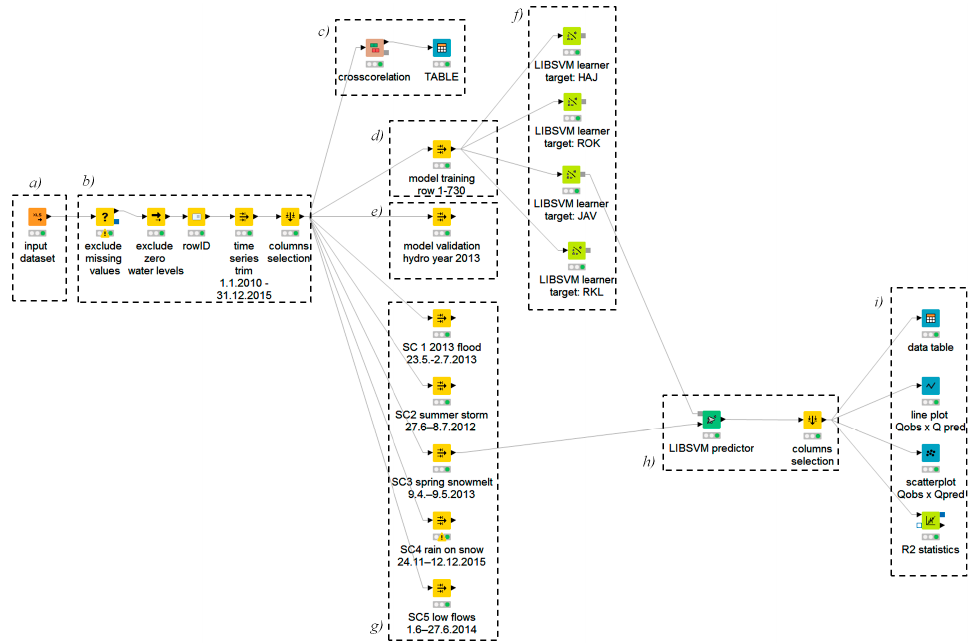
Figure 4. Structure and components of the model as defined in the KNIME workbench. The annotations highlight the principal functional blocks of the model, based on nodes, linked into in the workflow: ( a ) input data; ( b ) data selection and pre ‐ treatment; ( c ) cross ‐ correlation analysis; ( d ) selection of data for model training period; ( e ) selection of data for model validation; ( f ) model learning modules for individual catchments; ( g ) selection of data for simulation scenarios; ( h ) model predictor; and ( i ) post ‐ processing of simulation outputs.